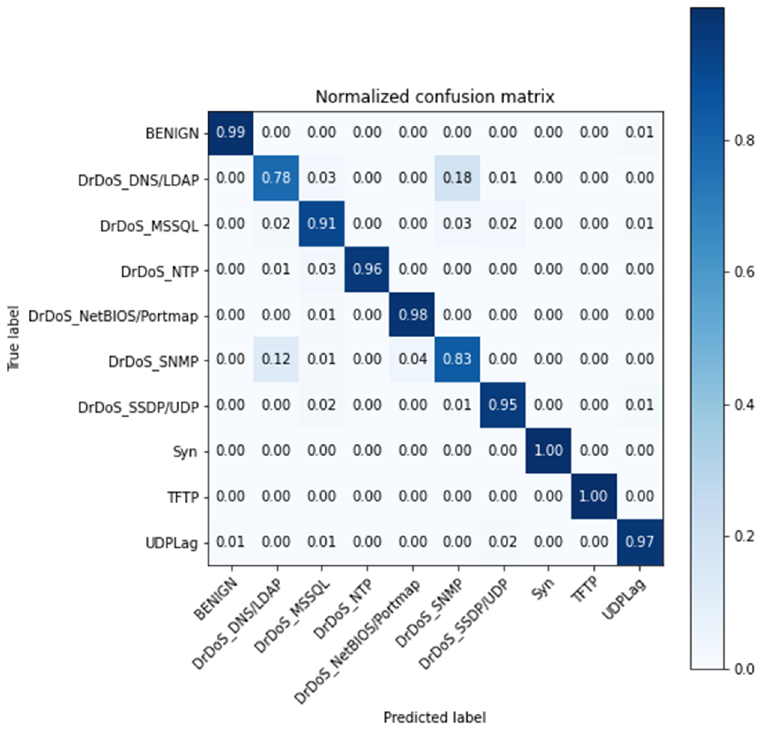
Figure 5. Confusion matrix for the third scenario.